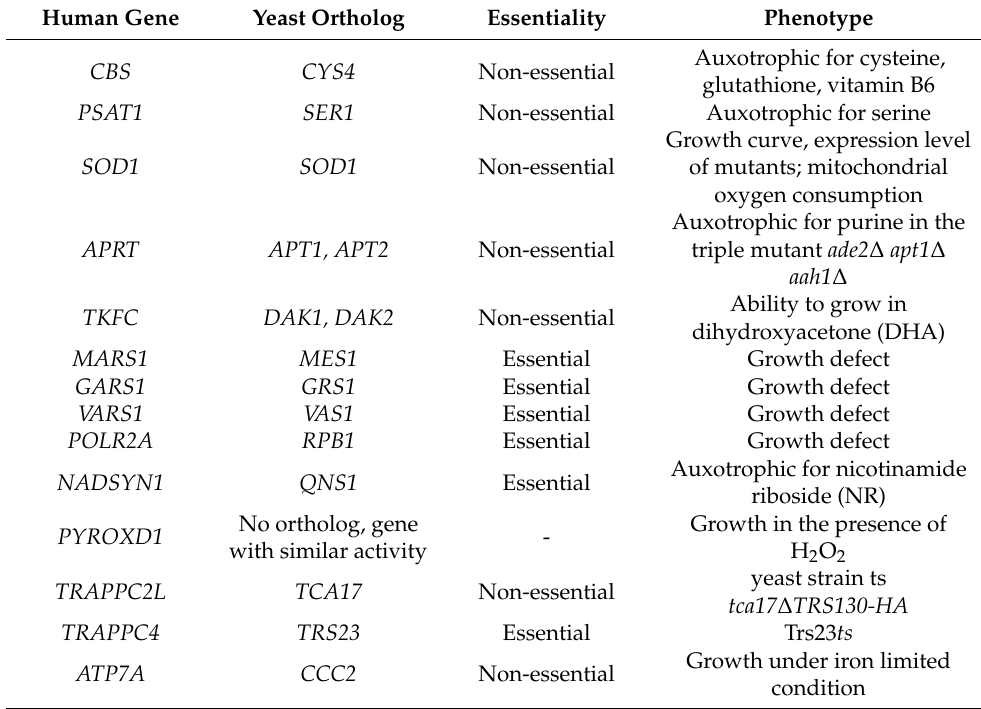
Table 2. Functional assays of genes listed in Table 1 and described in the